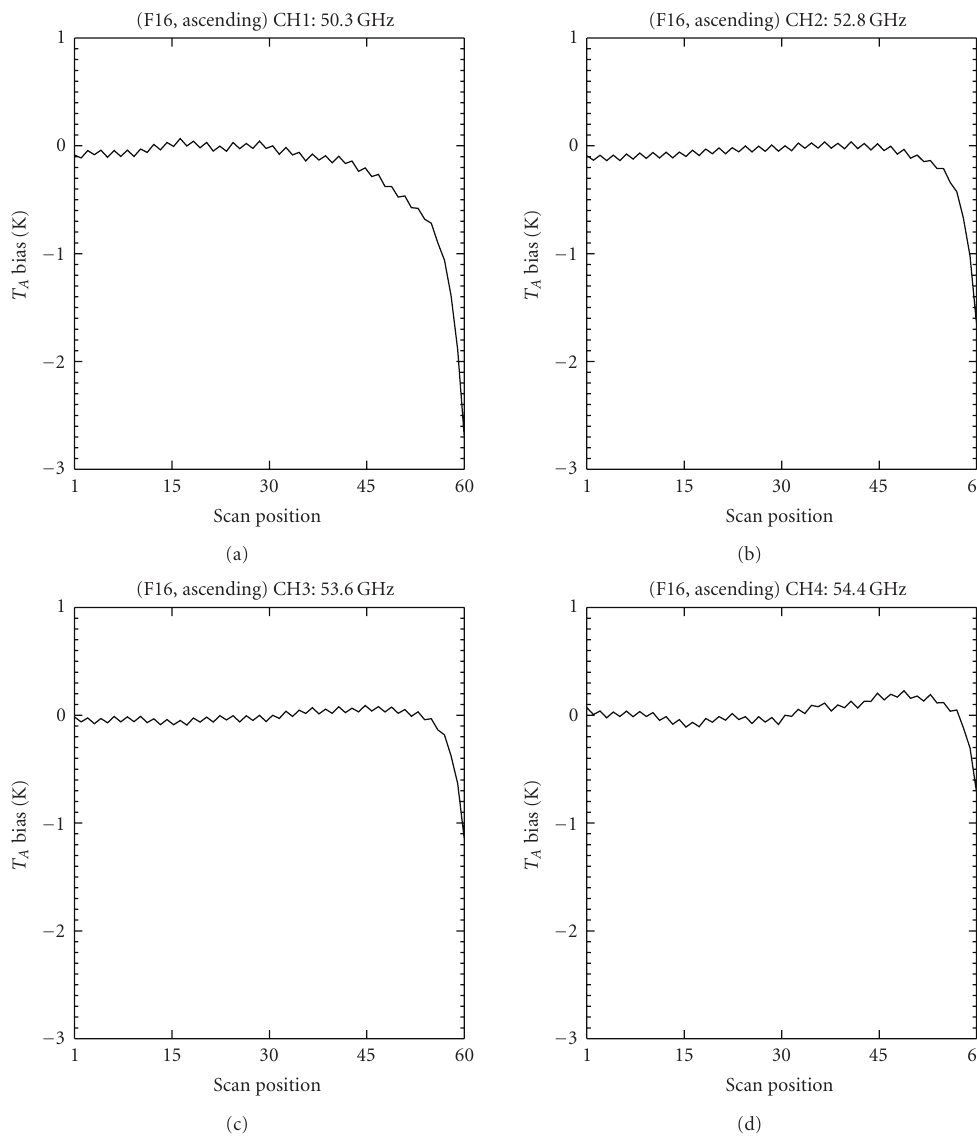
Figure 12: SSMIS antenna temperature ( T A ) scan-dependent bias in ascending node at several LAS channels [23]. (a) 50.3 GHz. (b) 52.8GHz. (c) 53.6 GHz. (d) 54.4